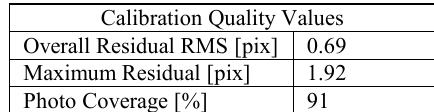
Table 2. Achieved accuracy of terrestrial images project